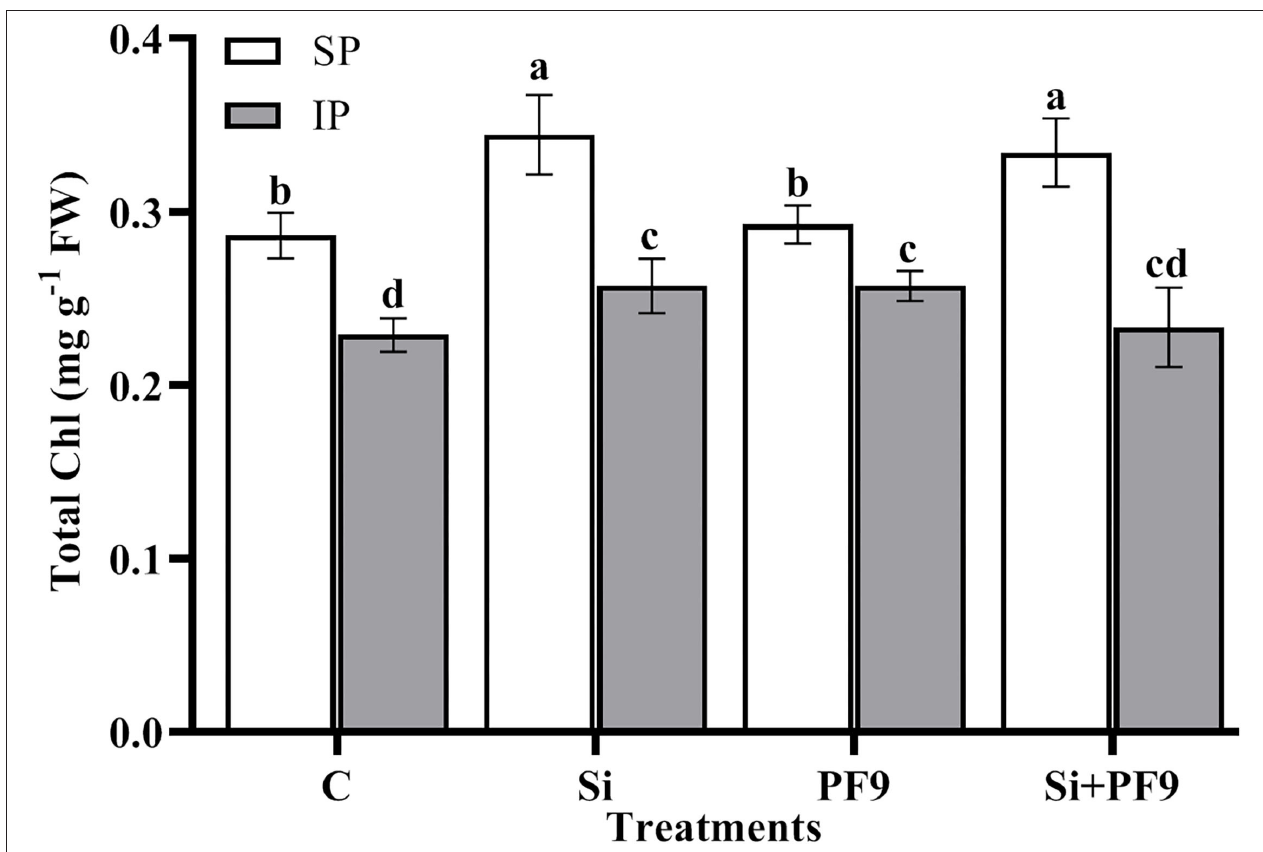
FIGURE 1 | Effect of 3mM Si treatment and PF9 strain inoculation on total chlorophyll (Chl) of Medicago sativa ( OL population) plants grown under 250 µ mol of either soluble (KH 2 PO 4 ) (SP) or insoluble (Ca 3 HPO 4 ) (IP) phosphorus conditions. Values are means of three replicates and error bars are SD. Different letters indicate significant difference at p <